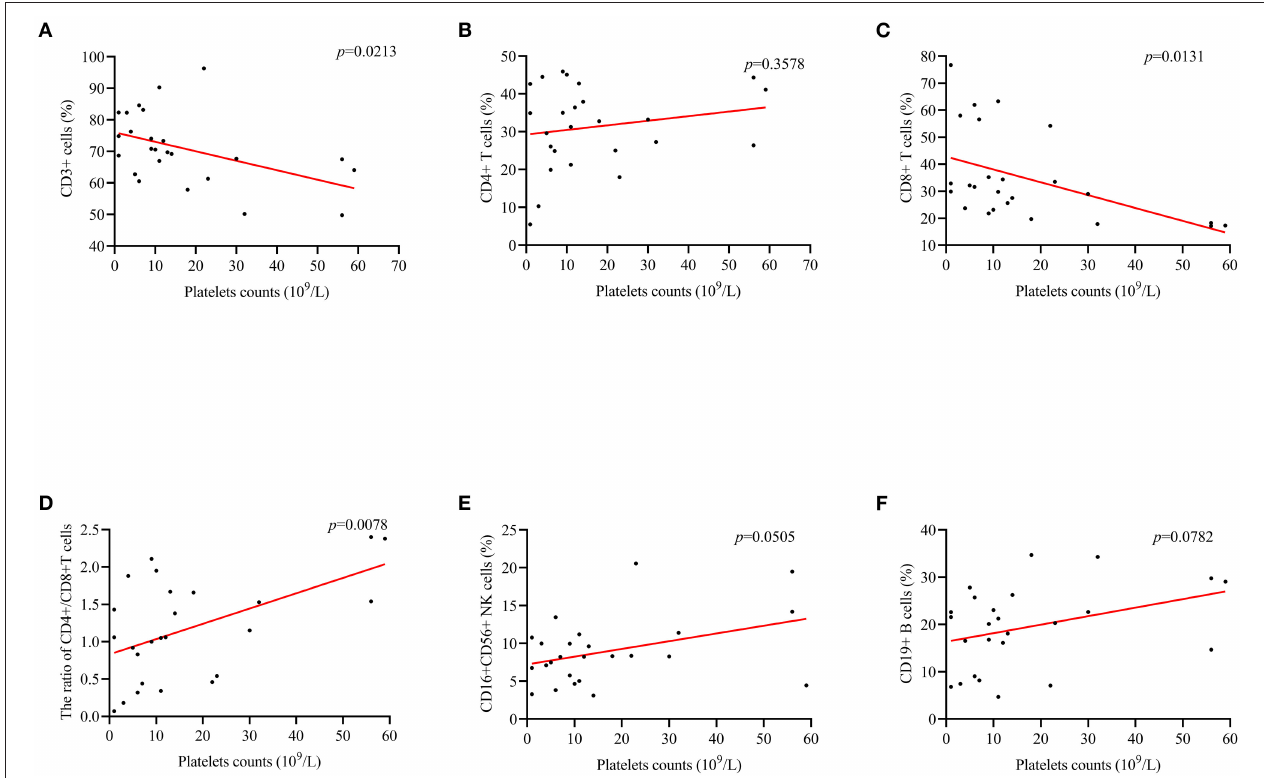
FIGURE 4 | The correlation between PLT counts and the levels of lymphocytes in subset. (D) PLT counts were positively correlated CD4 + /CD8 + cells ratio ( r = 0.519; p = 0.0008). (A,C) There was a negative correlation between PLT counts and CD3 + ( r = − 0.458, p = 0.0213), and CD8 + ( r = − 0.489, p = 0.0131). (B,E,F) Differences in CD4 + , CD16 + 56 + , and CD19 + cells were not observed.